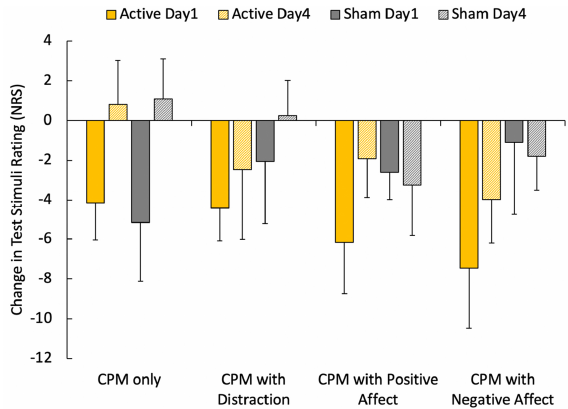
Figure 2. Pain modulatory effect shown as change in numerical rating scale (NRS) pain ratings (mean +/− SEM) of test stimuli normalized prior to conditioning under the 4 conditions of conditioned pain modulation (CPM) without and with manipulations (during distraction from the flanker task, positive affect induction and negative affect induction using an image series). Negative values indicate the expected inhibitory response. No significant interactions were observed, only a main effect of Day with greater modulation on Day 1 than Day 4 ( p < 0.02).